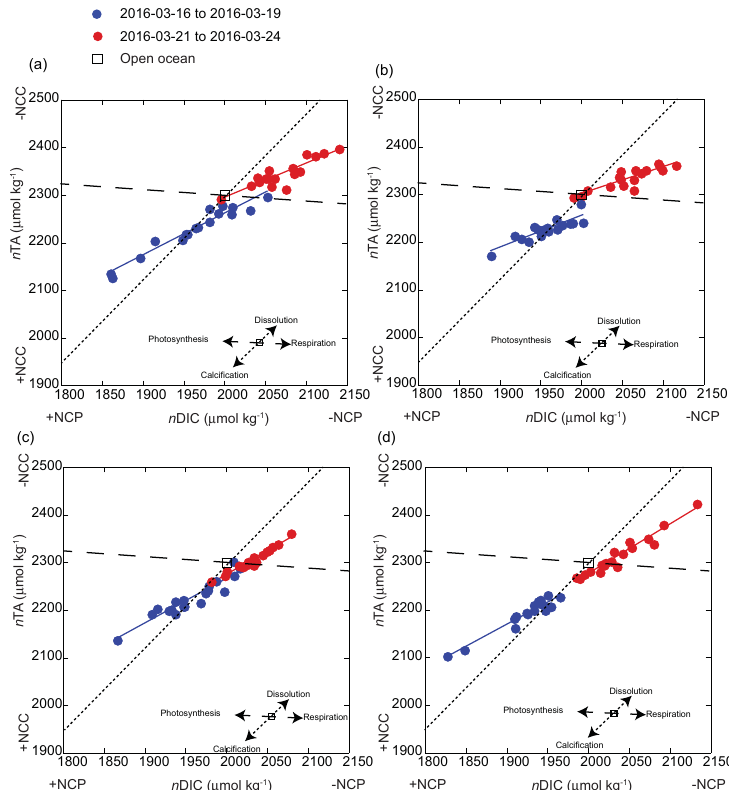
Figure 5. Seawater carbonate chemistry system along the reef flat off Kahekili as a function of n DIC and n TA for the shallow sampling sites (a) S1 and (b) S2, and two deeper sites (c) S3 and (d) S4, for the first (blue) and second (red) sampling periods and their respective slopes (solid lines) of n DIC and n TA (Table 1) and theoretical slope (dashed lines) given the predicted net effects of photosynthesis, respiration, calcification, and dissolution as shown in panels (a–d) , and the respective change in net community calcification (NCC) and net community production (NCP). The relative positions of the open-ocean n DIC and n DIC values are reported as 1977 ± 11 and 2304 ± 5µmolkg − 1 (adapted from Dore et al.,